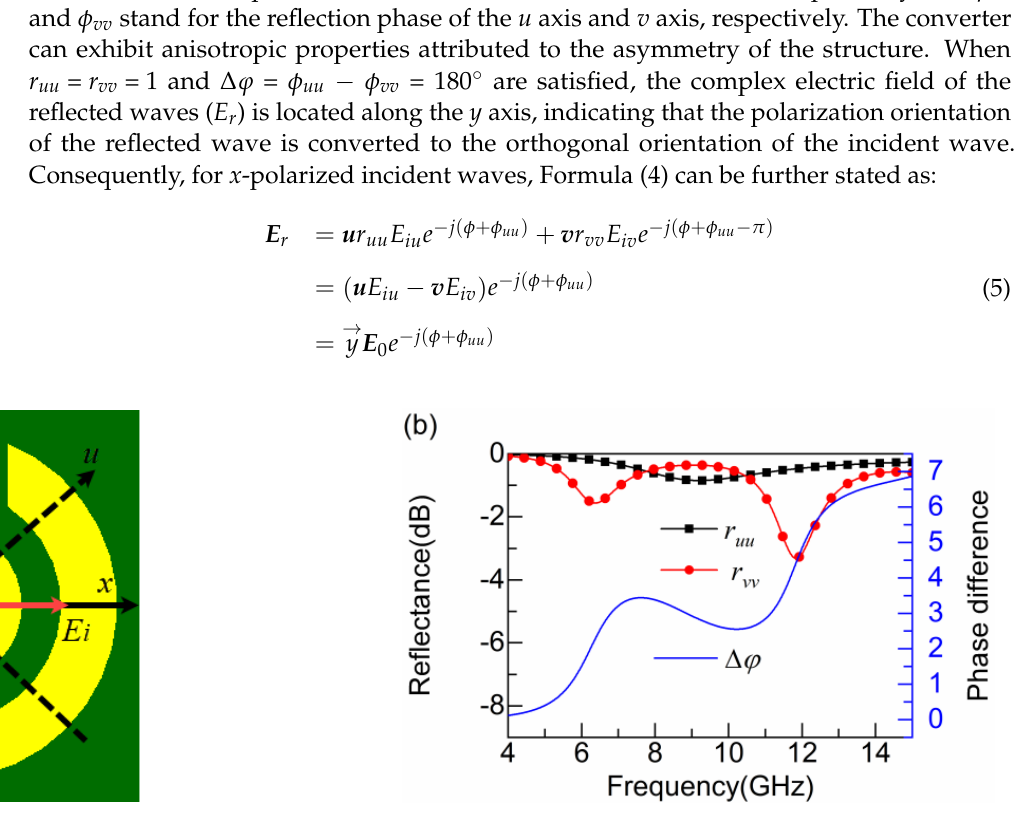
Figure 3. ( a ) Electric field decomposition diagram; ( b ) reflectance and phase difference in the u , v direction.